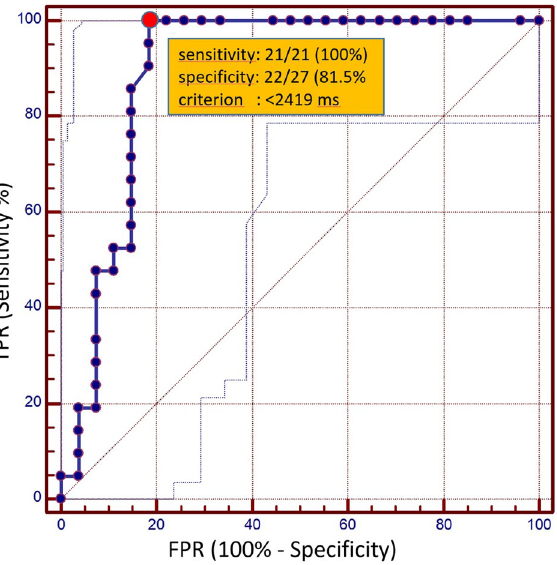
Figure 5. ROC curves. Receiver operating characteristic (ROC) curves for MOLLI T1 relaxation time based differentiation of malignant and non-malignant effusions from ex vivo analysis (AUC: 0.89). The red dot indicates the best performing cut-off value (criterion: T1-relaxation time < 2419 ms) for the MOLLI T1 Mapping technique with a sensitivity of 100% (95% CI 83.9–100%) and a specificity of 81.5% (95% CI 61.9–93.7%) and a corresponding AUC of 0.89 (95% CI 0.77 to 0.964) in the differentiation of malignant and non-malignant effusions. The dotted lines indicate the 95% confidence interval. TPR: true positive rate; FPR: false positive